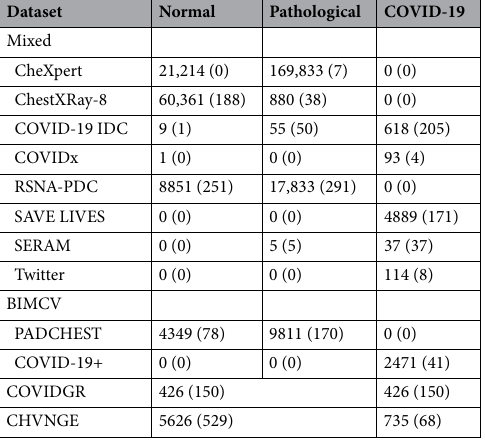
Table 1. Number of CXRs per dataset and (number of CXRs annotated by radiologists) for each of the three classes after exclusion of non-frontal CXRs.